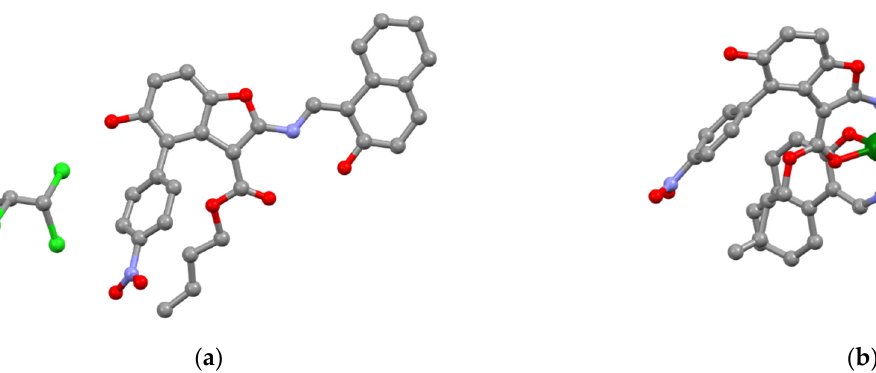
Figure 4. Ball-and-sticks representation of L ( a ) and L 2 Zn complex ( b ) crystal structures. Atoms are color-coded as follows: carbon (gray), oxygen (red), nitrogen (blue), zinc (dark green), chlorine (light green). Table 2. Data collection and refinement statistics for L and L 2 –Zn